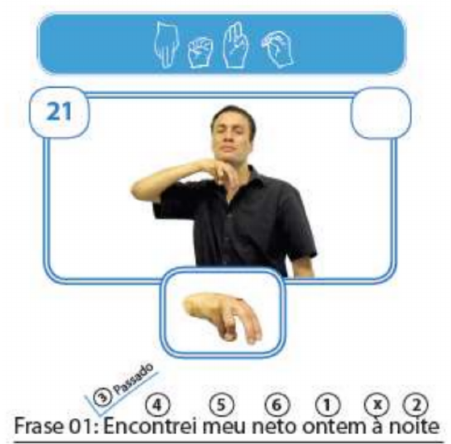
Fig. 1. Example of Semantic Numbers [14, p.